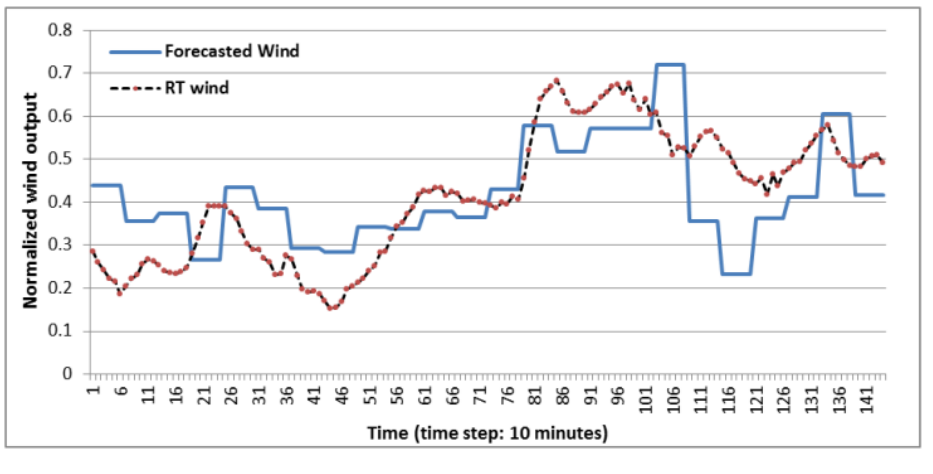
Figure 4. Forecasted wind vs. actual wind.